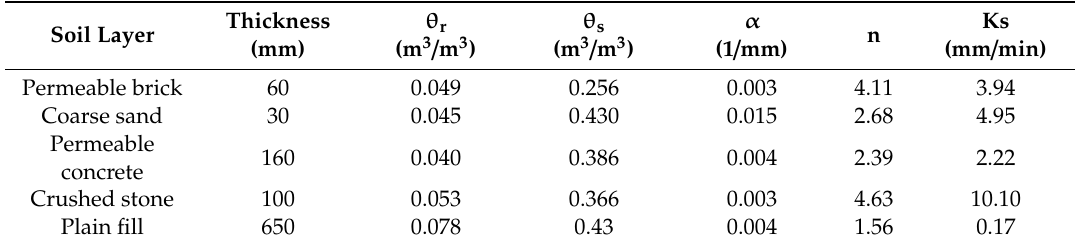
Table 2. Layered structure and hydraulic parameters of the designed permeable brick pavement (PBP) from top to bottom layers.